Question: In one sentence, what is this figure communicating?
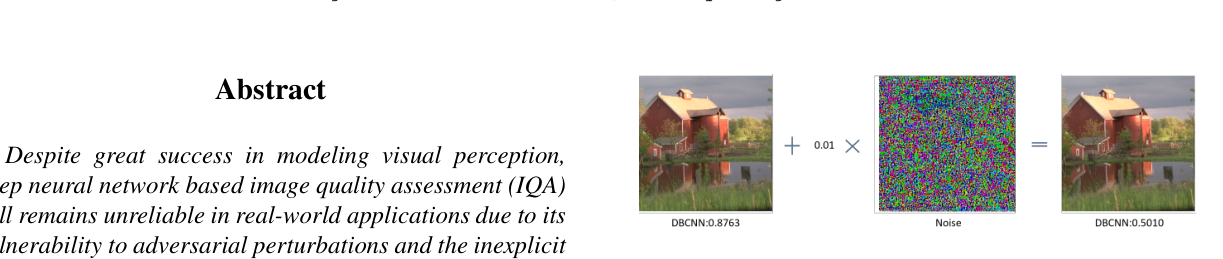
Answer: Demonstration of IQA model adversarial example gen- eration). By adding an imperceptible perturbation, we can drasti- cally change the predicted score of an IQA model for an image.